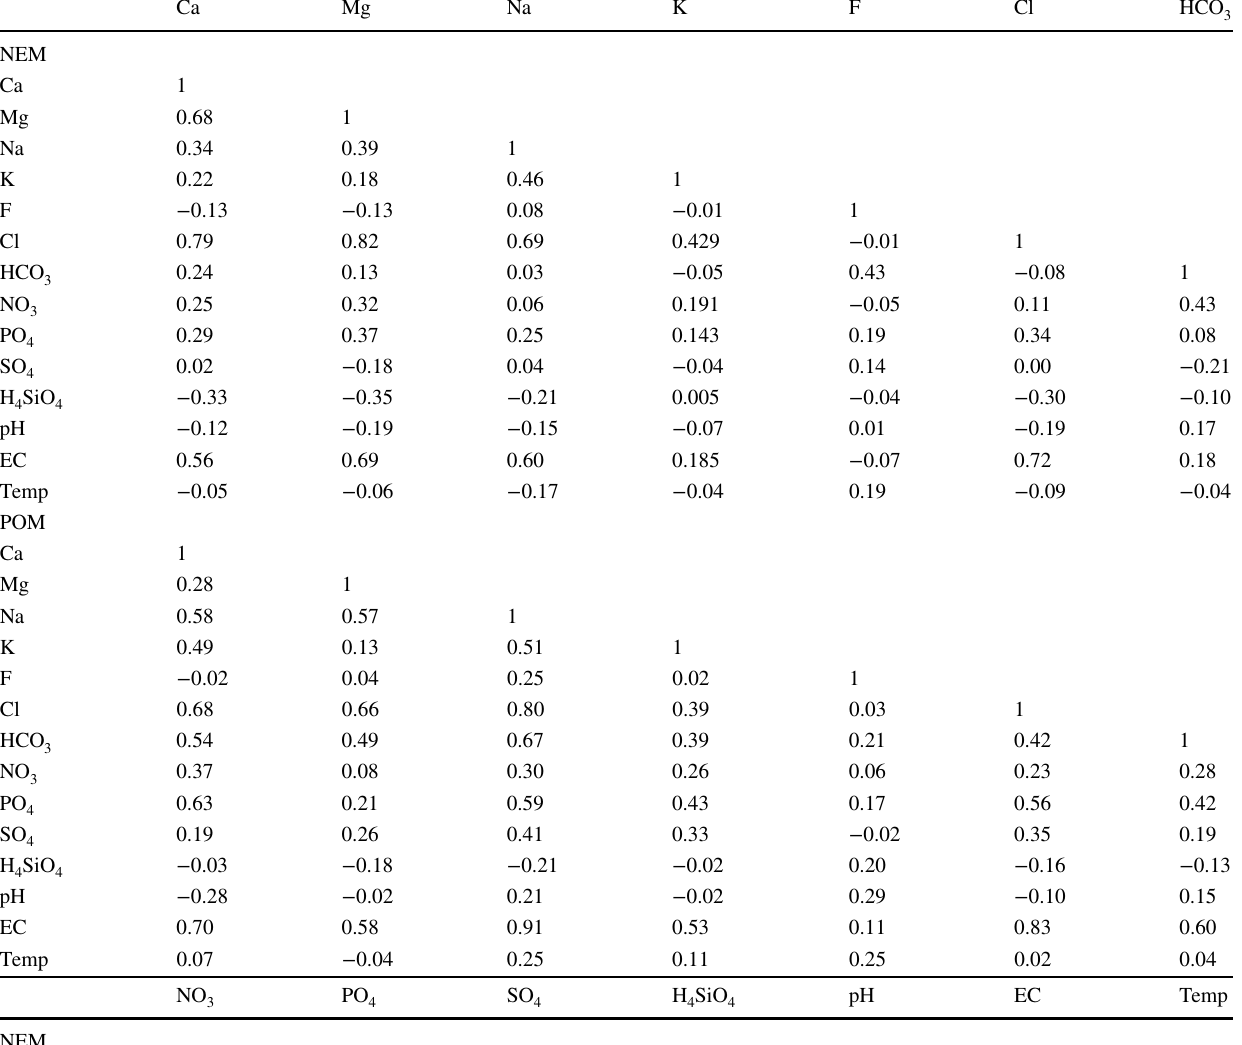
Table 7 Correlation matrix of hydrogeochemical parameters for northeast and post-monsoon seasons Ca Mg